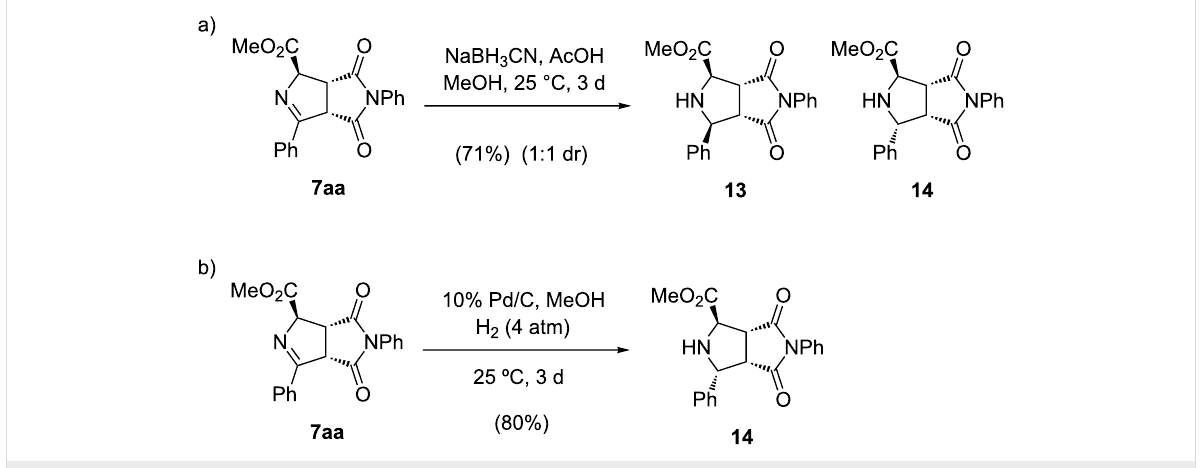
Scheme 7: Reduction of heterocycle 7aa under different conditions.